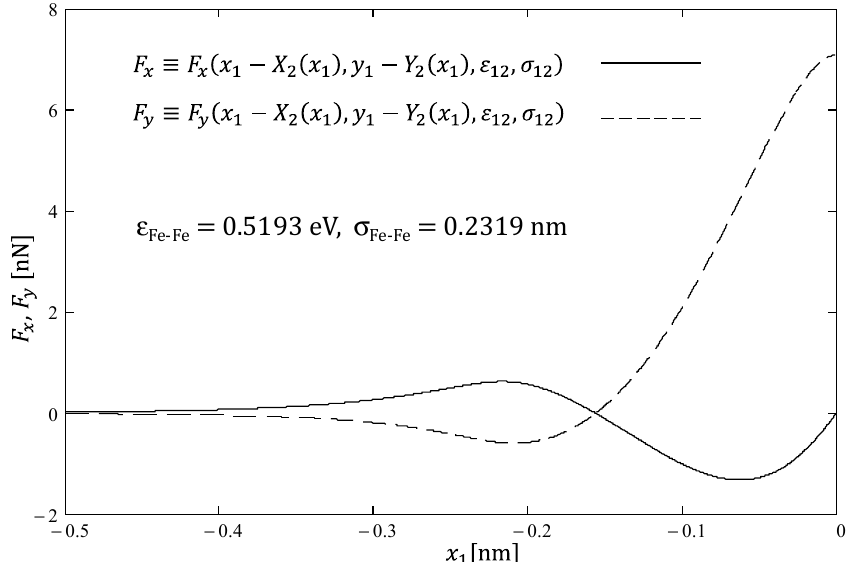
Figure 2. The exemplary dependences of lateral ( x ) and normal ( y ) forces acting on “sliding” atom (1) from the “slab” atom (2) in 2D iron “crystalline lattice” for y 1 = h = 0.208 nm as a function of the position of atom (1).